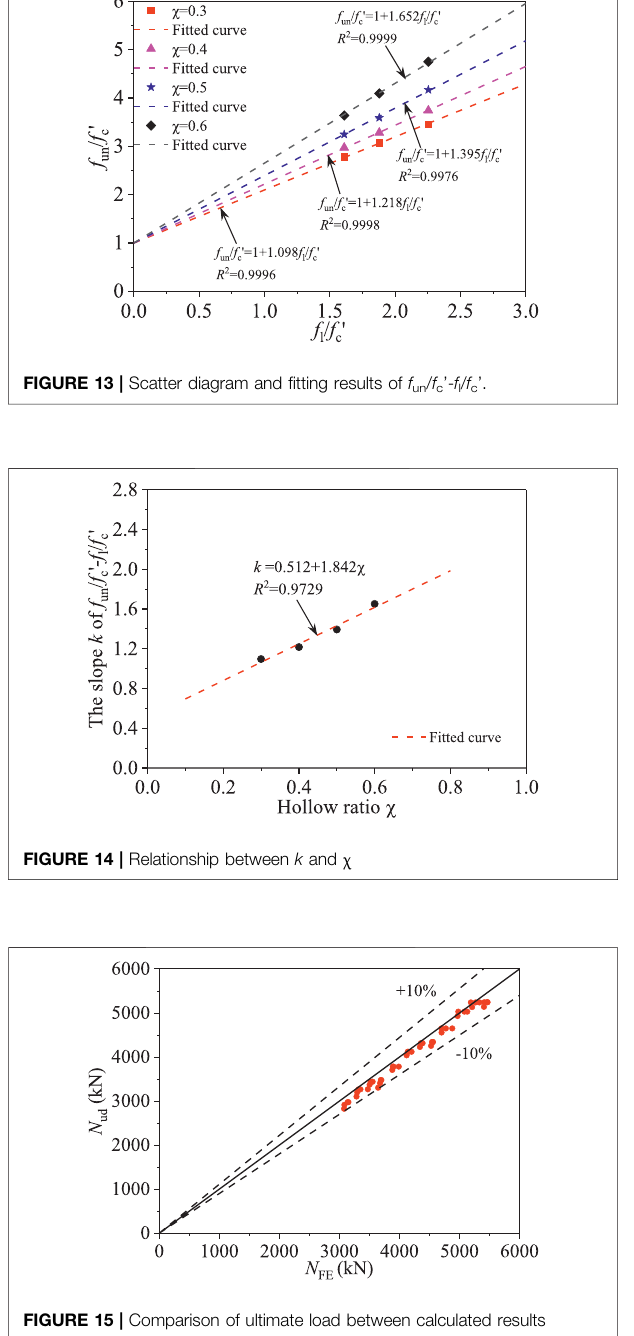
Frontiers in Built Environment |